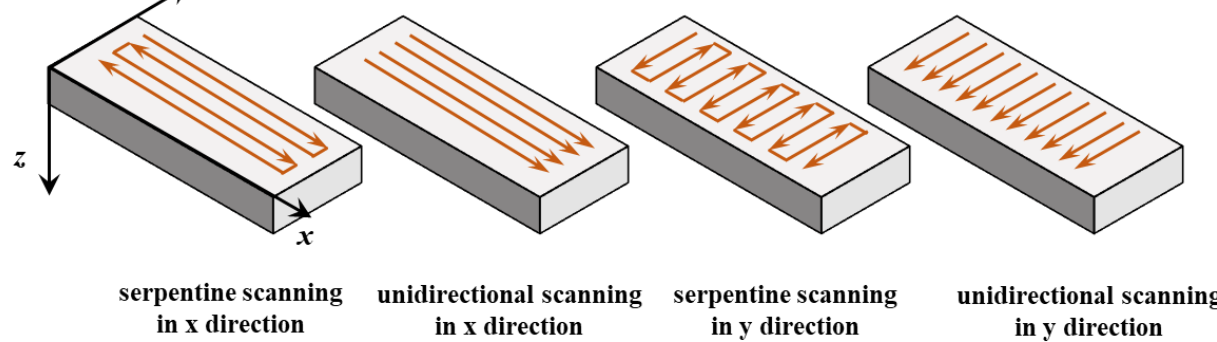
Figure 8. Four scanning modes in repair.